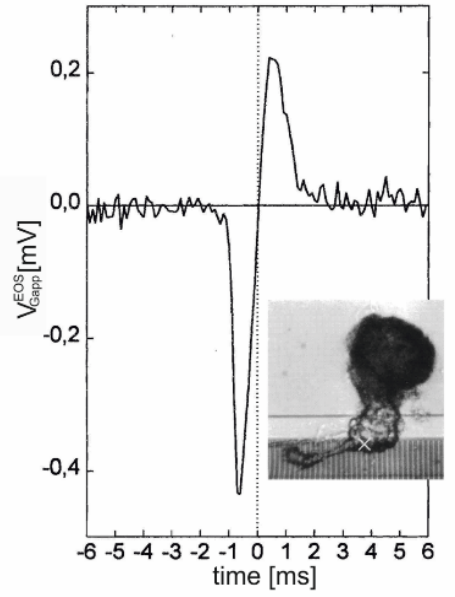
Figure 10. Transistor recording of an action potential beneath the axon stump of a leech neuron (by permission [44]). The apparent change of the gate voltage δ V EOS was observed with the transistor Gapp of a linear array as marked in the micrograph. The biphasic negative-positive signal reflects the extracellular voltage V J “ δ V EOS as induced by the local ion currents in the cell-substrate Gapp